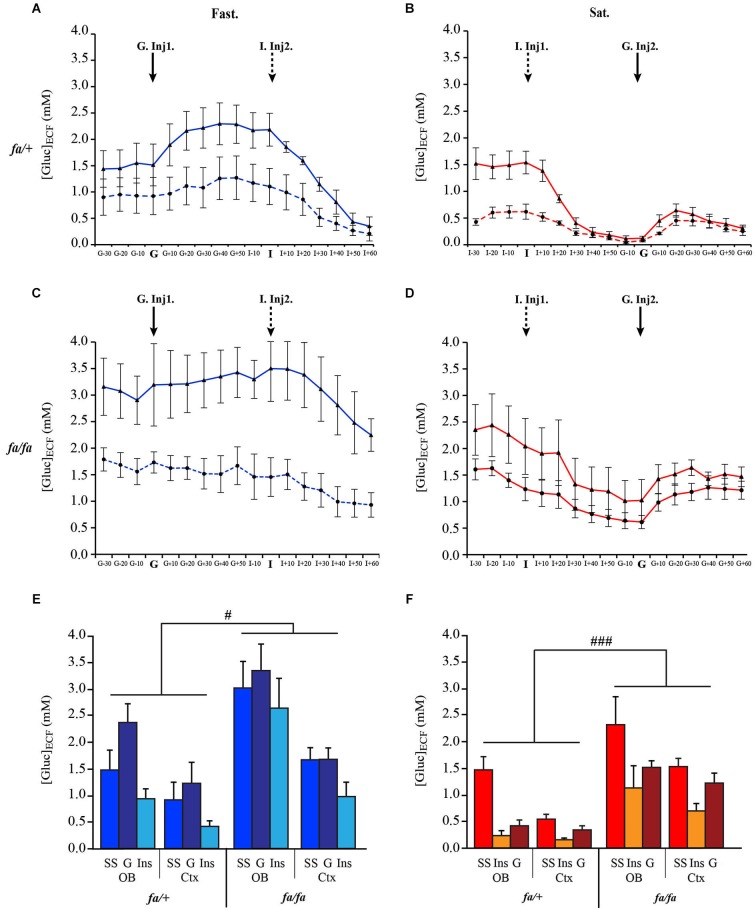
Genotype effect on the dynamic response of [Gluc]ECF in OB and cortex to glucose and insulin peripheral injections. Composite figures compiled from in vivo real time recordings of [Gluc]ECF, performed simultaneously in OB (full line) and cortex (Ctx, dotted line) of lean fa/+
(A, B) and obese fa/fa rats (C, D) in fasted (A, C: Fast., blue) and satiated (B, D Sat., red) states. In fasted rats, glucose was injected in first (G. Inj1), and insulin in second (I. Inj2). The order of injections was reversed in satiated rats (I-Inj1, G-Inj2). For fasted (E) and satiated (F) rats, mixed ANOVA revealed a significant effect of genotype (in fasted rat #
P < 0.01; in satiated rats ###
P < 0.0005), conditions (not shown) and brain areas (not shown). SS: steady State; G: glucose; I: insulin.